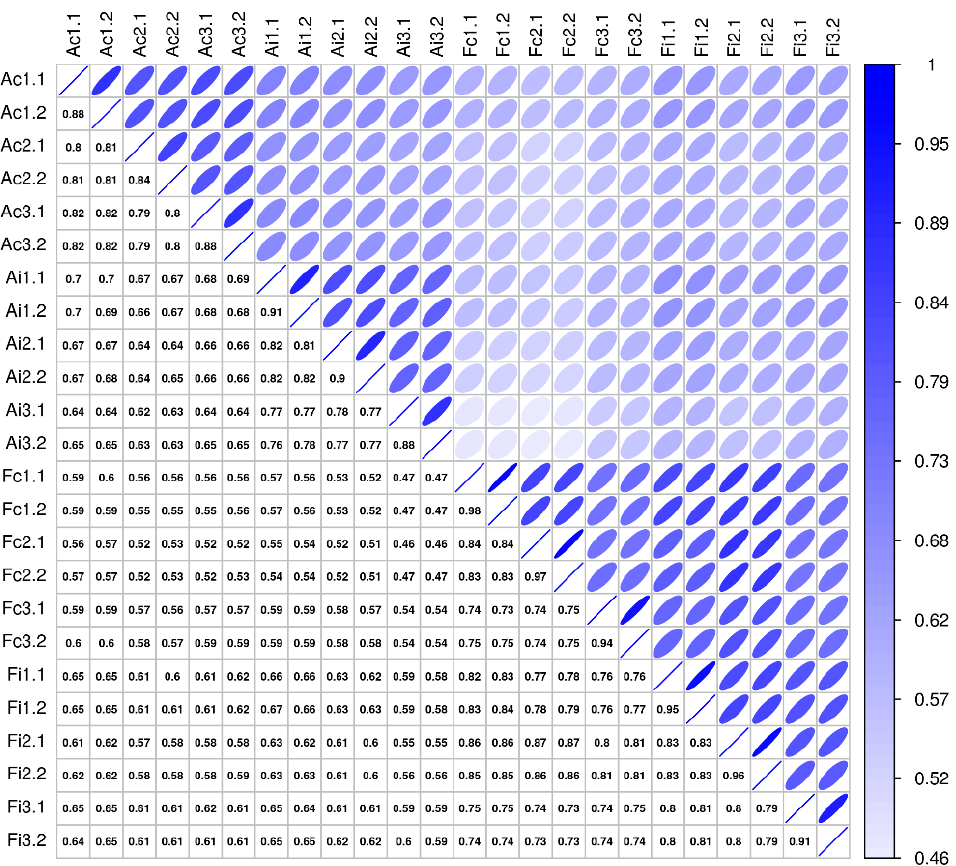
Figure 6. Sample correlation structure. This figure compares pairwise sample correlations: Spear ‐ man rank correlation coefficients are given in the boxes below the diagonal, and correlations are visualized above the diagonal (darker and narrower ellipses indicate higher correlations). Rows and columns show sample labels, where A/F = adult/fetal, c/i = control/injured, and #. # show biological and technical replicate numbers ( n = 3 biological replicates per group, two technical replicates per biological replicate) .